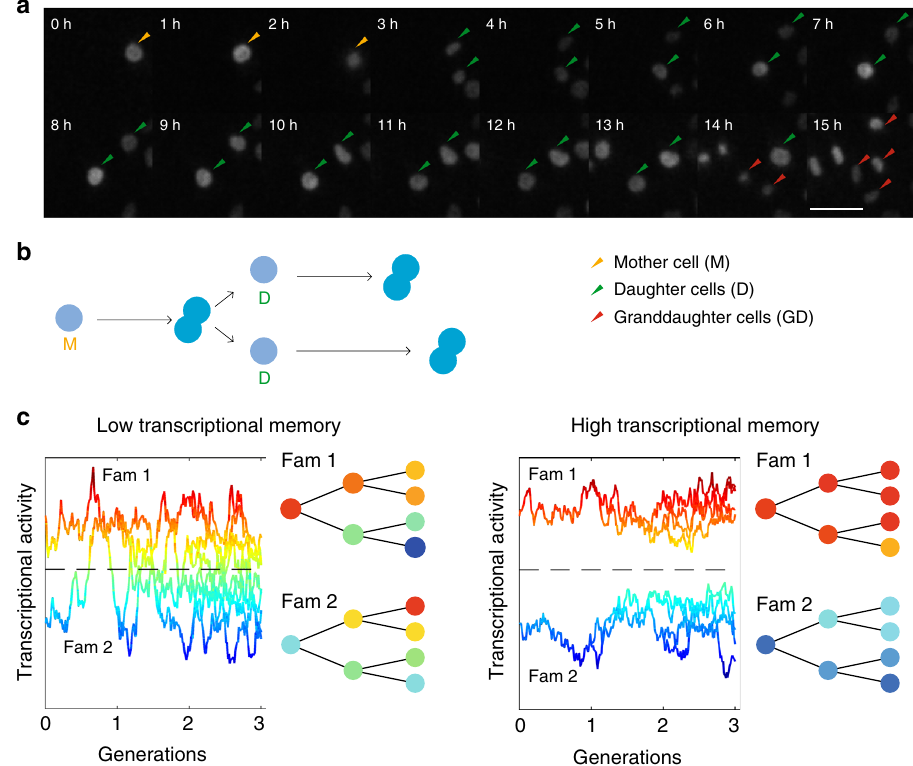
Fig. 1 Monitoring the propagation of transcriptional activity in proliferating cells. a A cell from the Rbpj reporter line progressing through two cell cycles. Luminescent cell nuclei are tracked manually. Scale bar: 10 μ m. b Representation of events in a . c Schematic of the transcriptional activity pro fi les over cell lineages in genes with short or long memory. Two families with either high or low initial transcriptional activity with respect to the population average (dotted black line) are shown